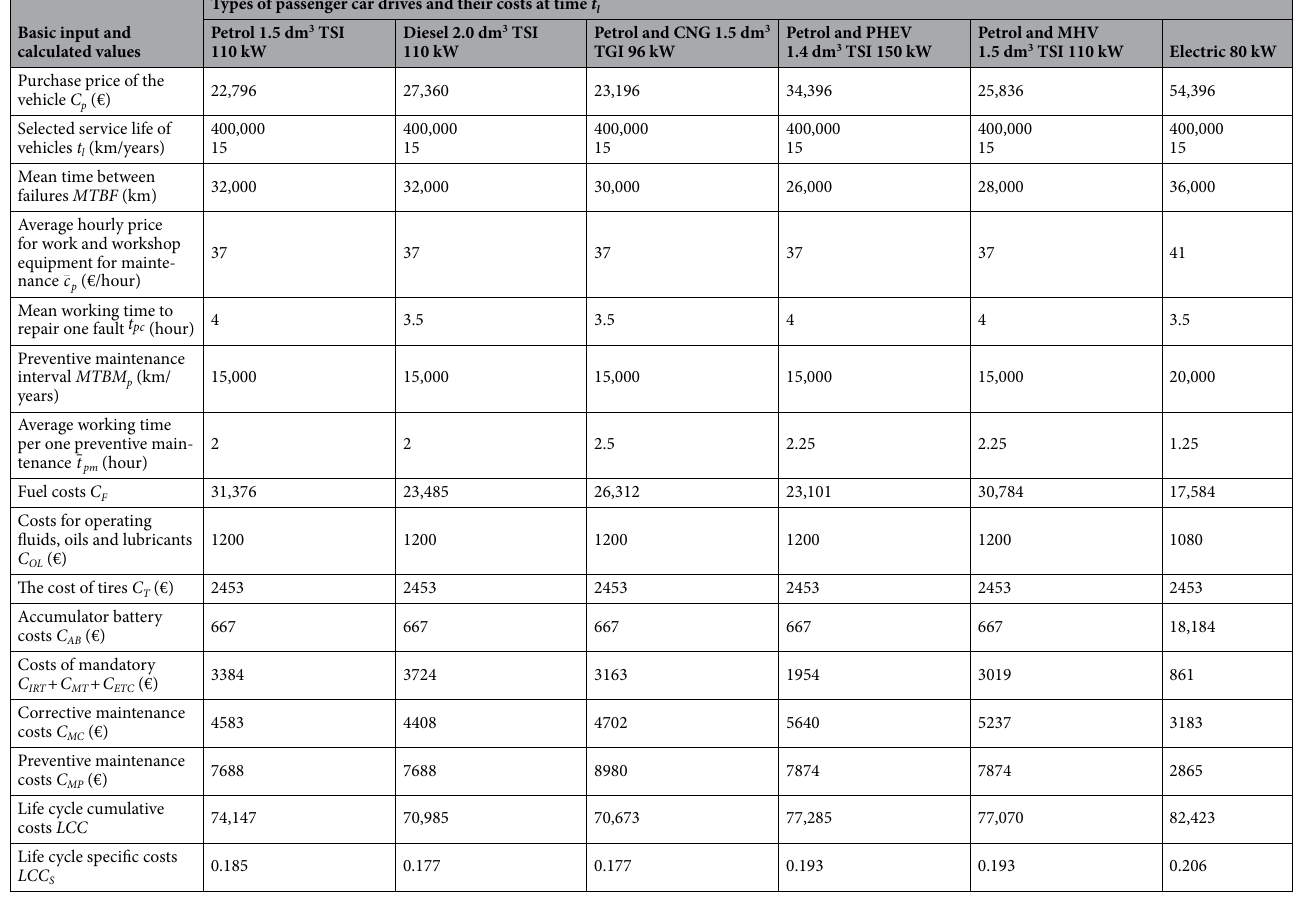
Table 1. Basic input and calculated values for selected passenger car drive